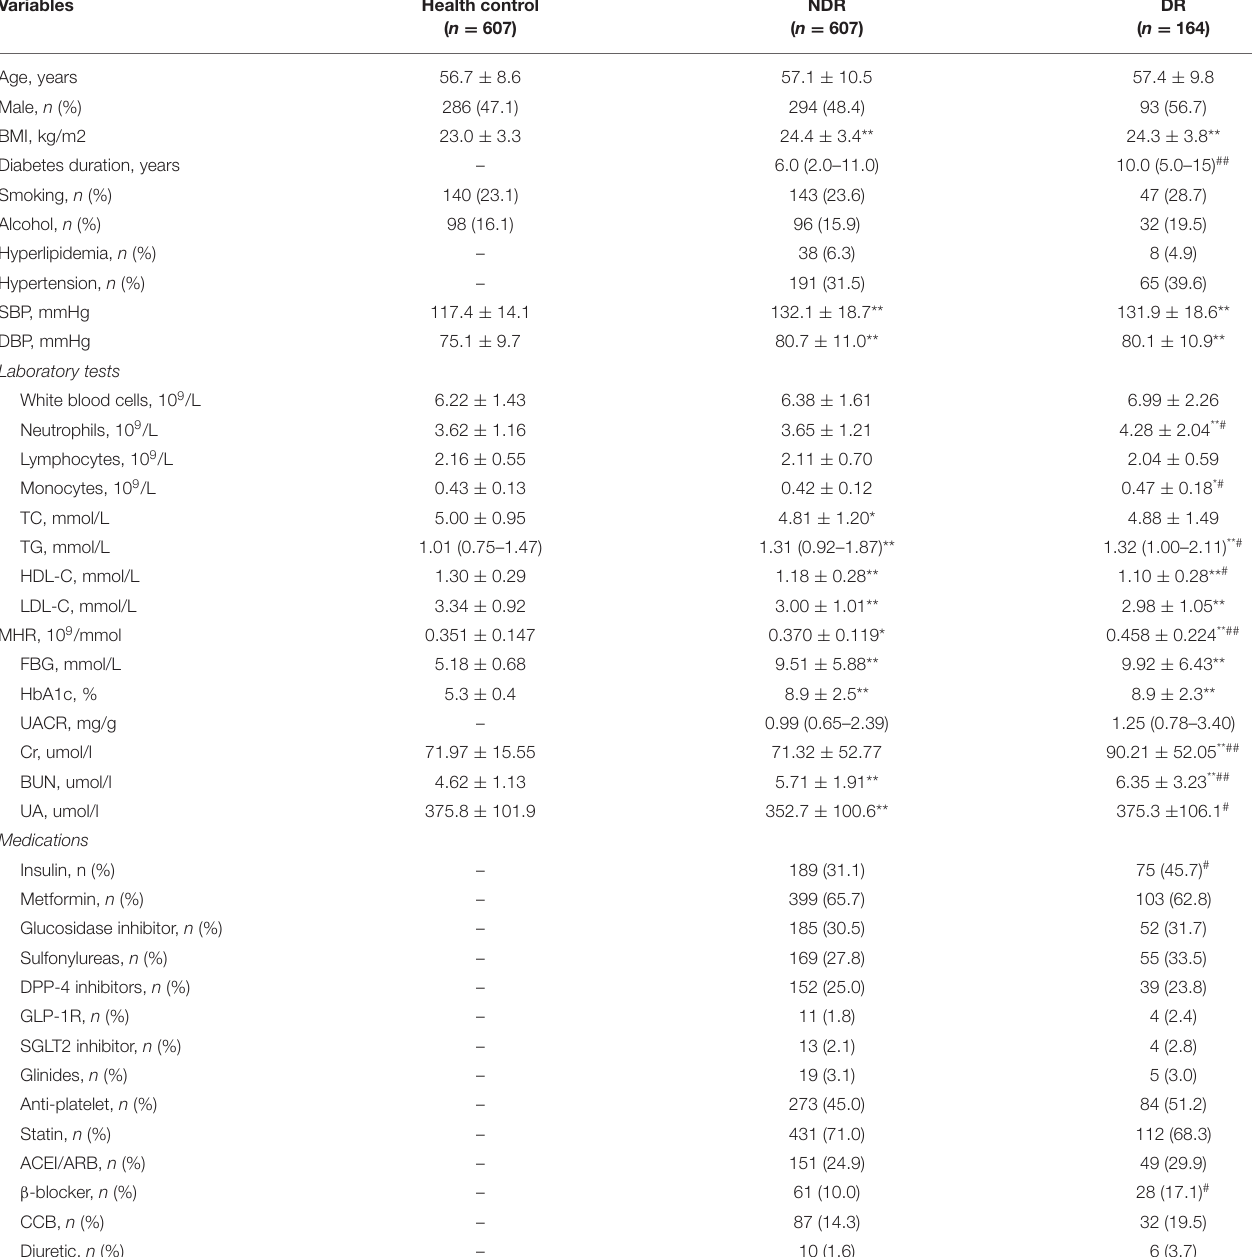
TABLE 1 | Baseline